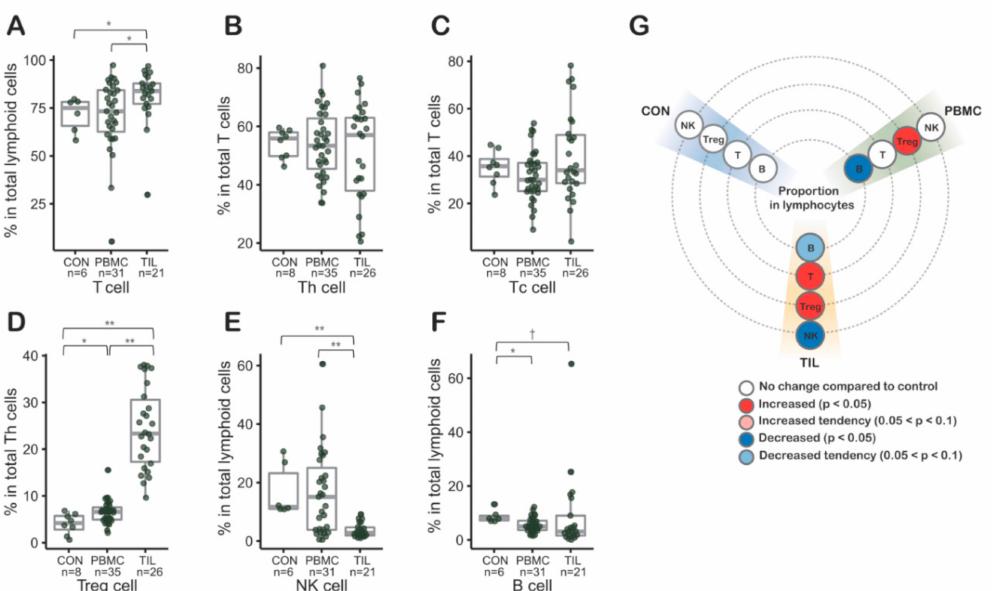
Figure 1. ( A – F ) Lymphocyte subsets in tumor infiltrating lymphocytes (TILs) and peripheral blood mononuclear cells (PBMCs) from colorectal patients ( n = 50) by flow cytometry. ( D ) Regulatory T (Treg) cells of tumor infiltrating Th cells were proportionally significantly increased. In PBMCs from colorectal cancer (CRC) patients, the proportion of Treg cells in Th cells was also significantly increased. ( E ) The proportion of NK cells decreased in TILs. ( G ) Graphic visualization summarizing the lymphocyte subset results. CON, control peripheral blood mononuclear cells from healthy blood donors; PBMC, peripheral blood mononuclear cells from colorectal cancer patients; TILs, tumor-infiltrating lymphocytes from colorectal cancer patients.; Th, helper T cell; Tc, cytotoxic T cell; Treg, regulatory T cell; *, p values < 0.05; **, p values < 0.01 in Mann-Whitney-Wilcoxon test ; middle line in box plot represents median and upper and lower sides are 1st and 3rd quantiles, respectively. Whiskers above and below the box plot represents values exceeding the 1st–3rd quantile